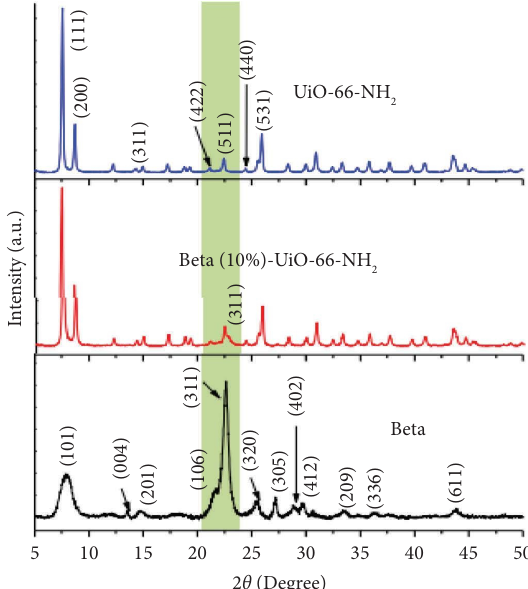
Figure 15: Powder XRD results of Beta, UiO-66-NH (10%)-UiO-66-NH 2 adopted from [40].